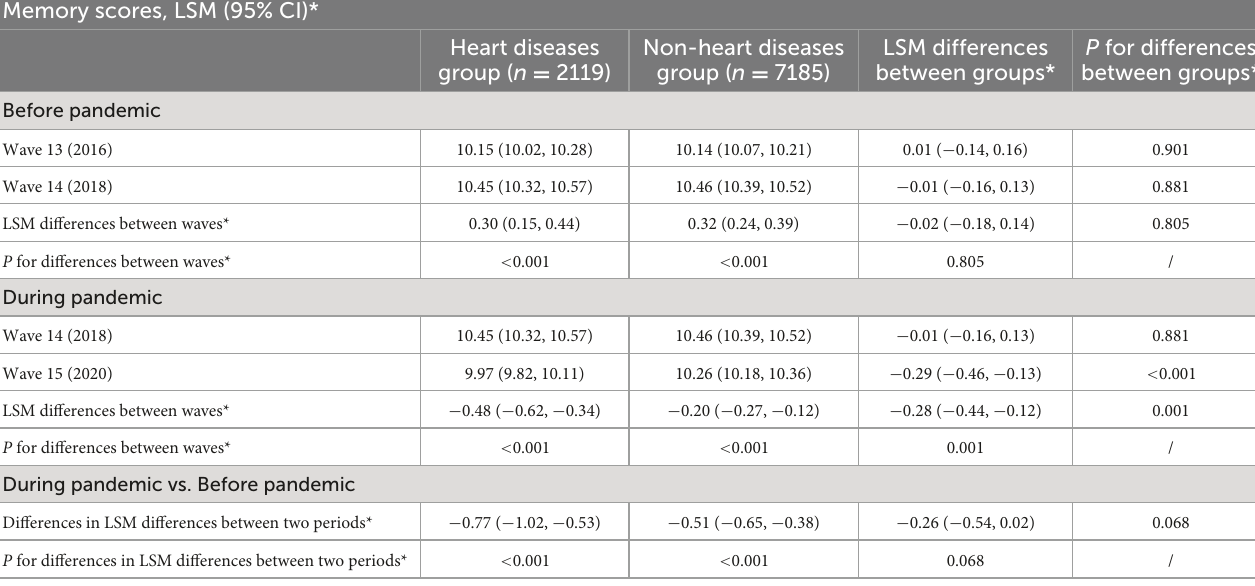
TABLE 3 Differences in the changes of memory scores before and during the pandemic period, by heart disease status. Memory scores, LSM (95% CI)*